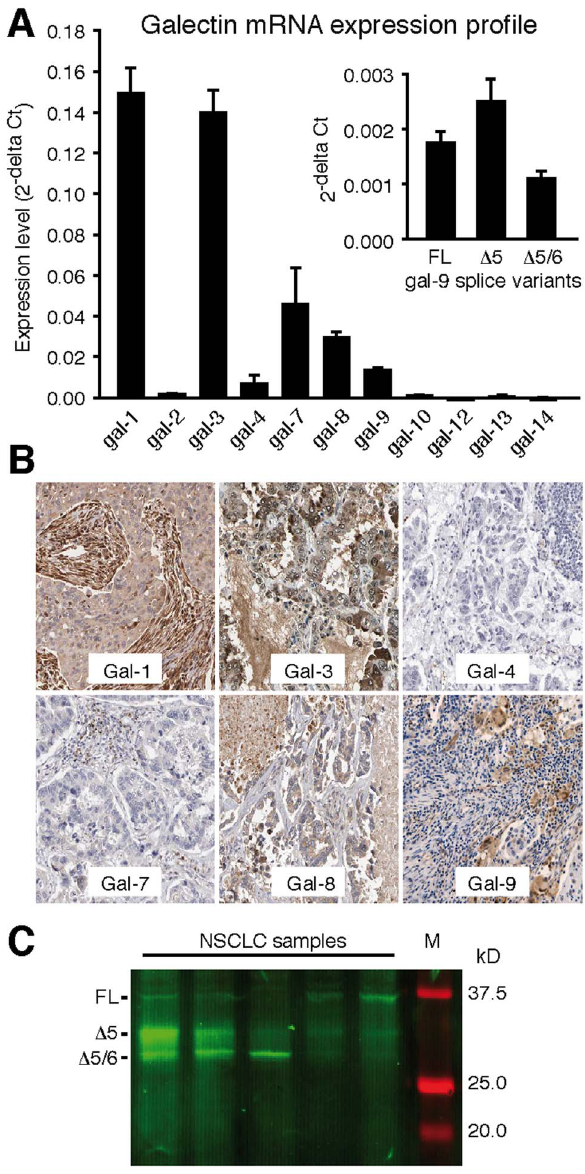
Table 1. Patient characteristics.